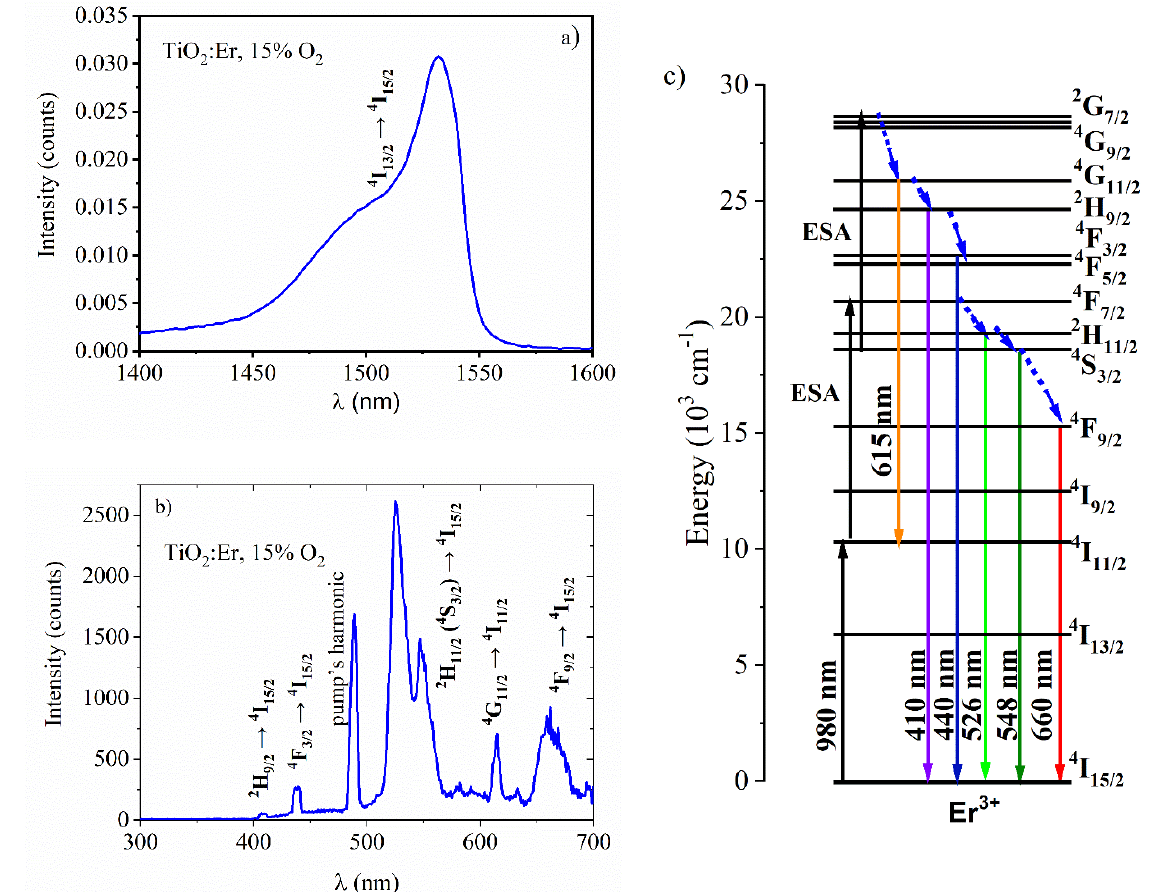
Figure 10. Luminescent properties of Er-doped TiO 2 thin films deposited at 15% O 2 excited with 980 nm laser: ( a ) photoluminescence spectrum, ( b ) up-conversion spectrum, ( c ) energy diagram in Er 3+ .